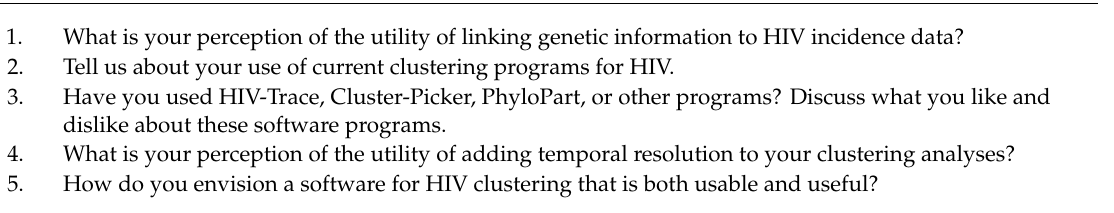
Table 1. Focus group open-ended question / prompt